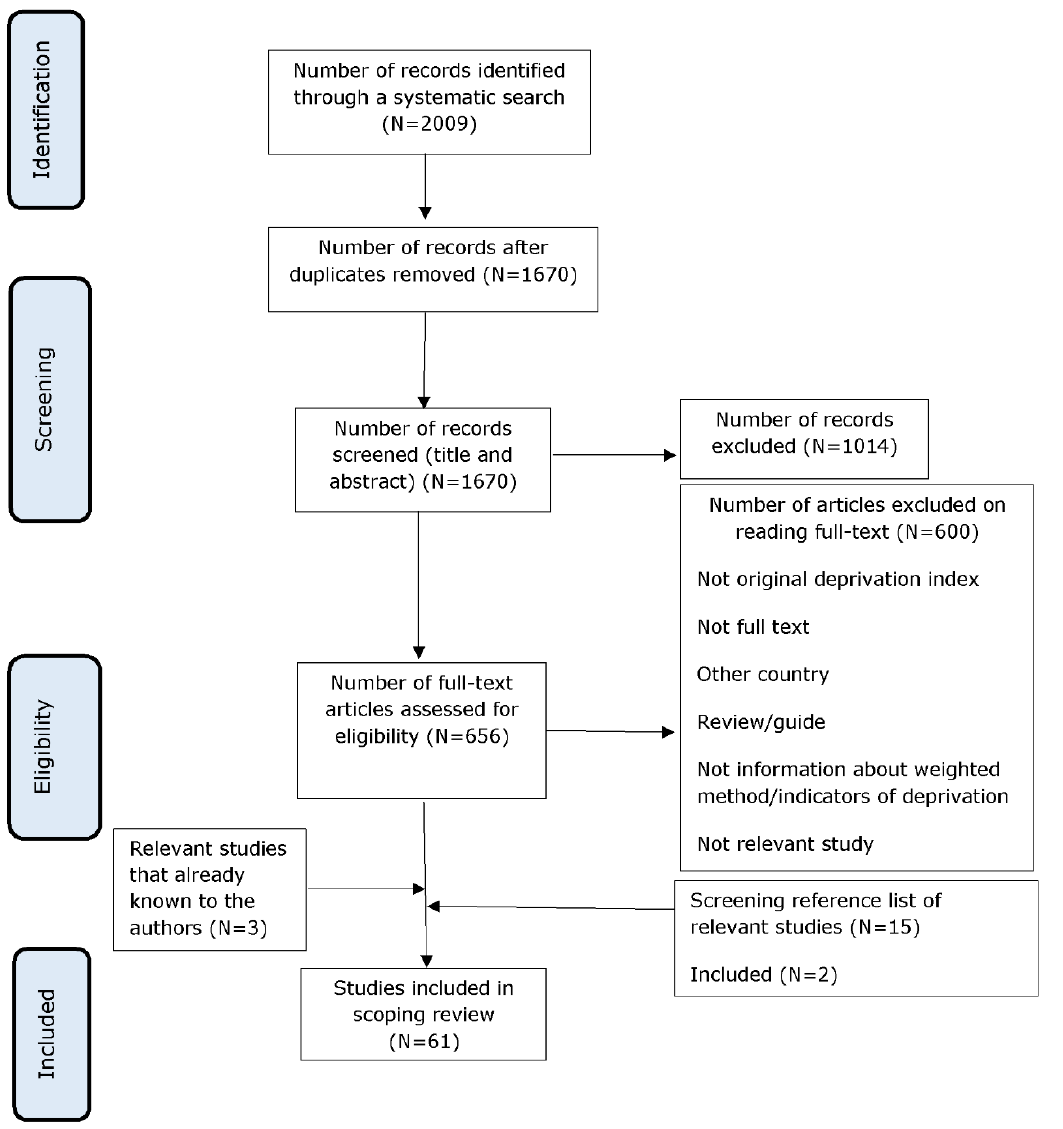
Figure 1. PRISMA-ScR flow diagram of search and study selection process. PRISMA-ScR: Preferred Reporting Items for Systematic Reviews and Meta-analyses for Scoping Reviews.